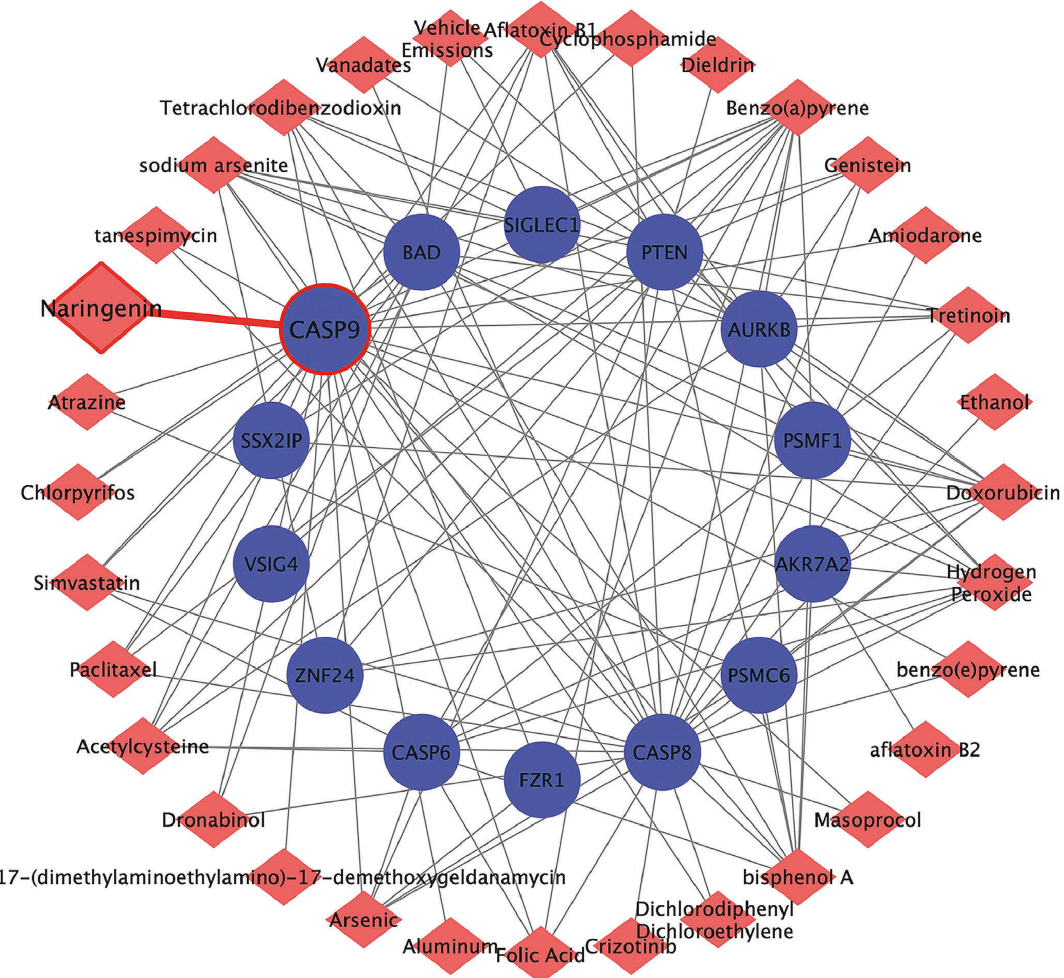
Figure 5: Establishment of gene-compound interaction network. Drug targets of hub genes using the data from CTD and visualized by cytoscape. Red: chemicals; blue: genes. Table 4: Relationship between CASP9 expression and clinical parameters of breast cancer patients using the bc-GenExMiner database. Variables Patient number CASP9 mRNA P -value ∗ ER <